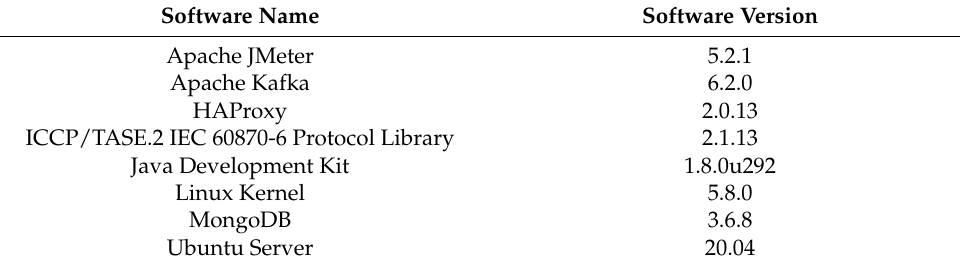
Table 2. Used software